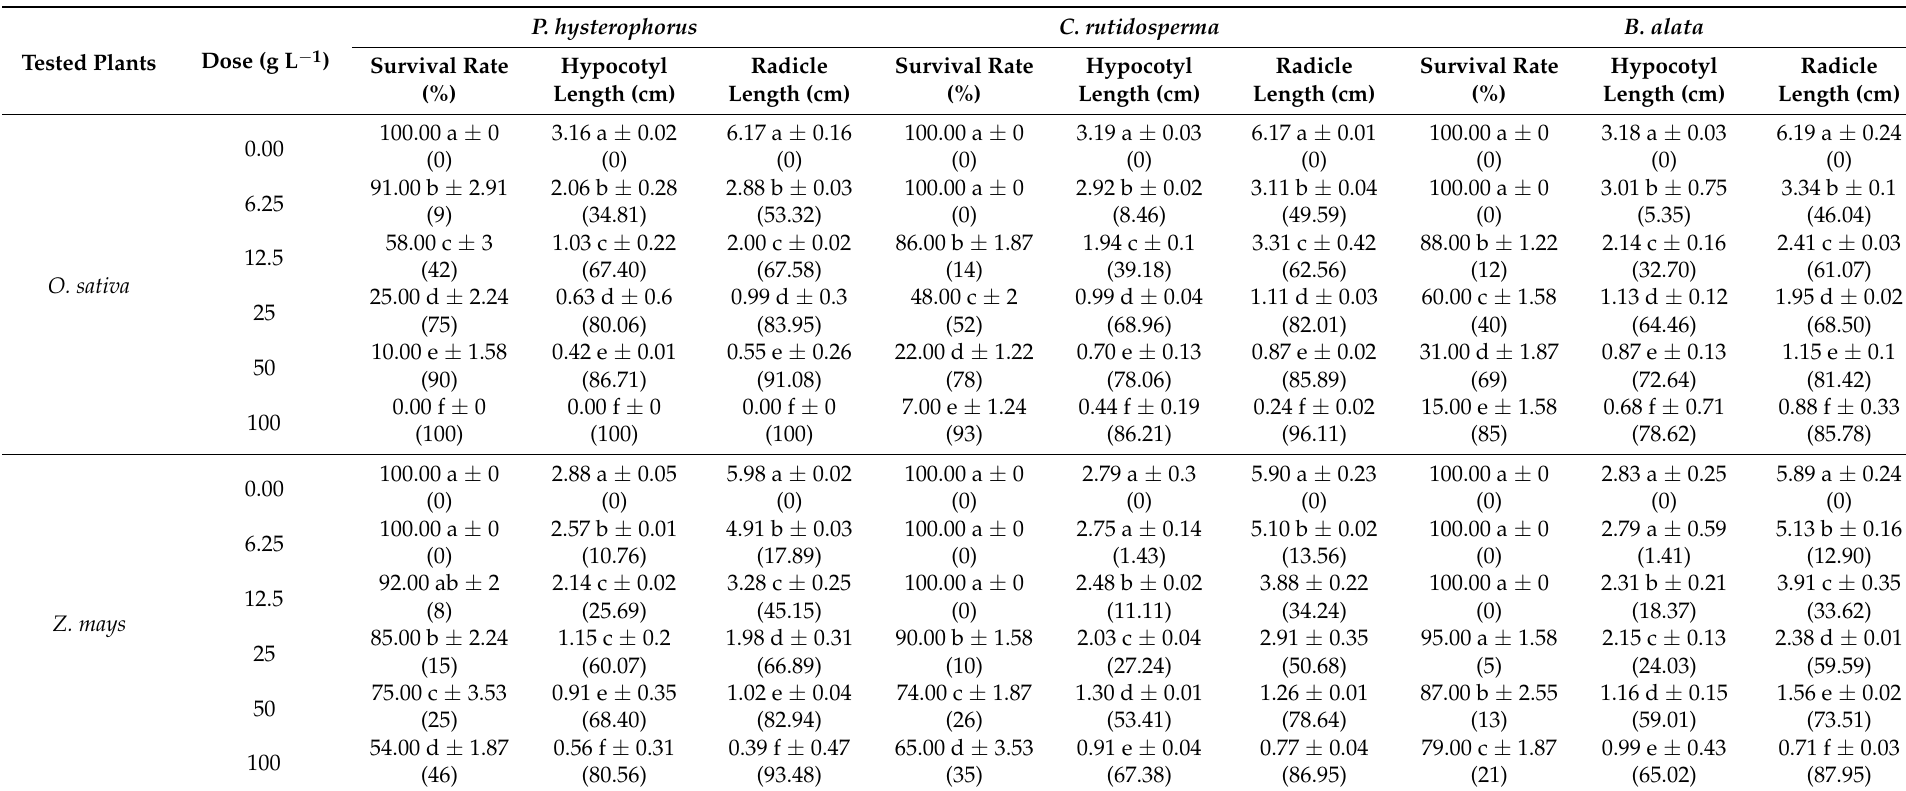
Table 2. Effects of P. hysterophorus , C. rutidosperma , and B. alata methanol extracts on survival rate (%), hypocotyl and radicle length (cm) of tested crops.